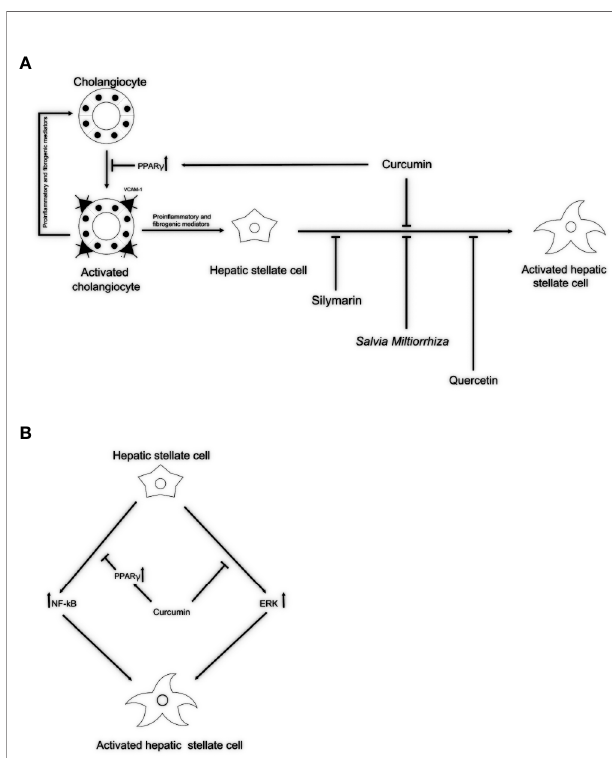
FIGURE 1 | Potential anti- fi brotic properties of natural remedies in cholangiopathies. (A) By activation of PPAR g , curcumin might block reactive cholangiocytes and their in fl ammatory activation through the reduction of VCAM-1 expression, resulting in decreased attraction of immune cells. Silymarin, Salvia miltiorrhiza, and quercetin might exert its anti fi brotic properties acting directly on HSCs activation. (B) In addition, acting as PPAR g activator and by inhibiting the ERK signaling curcumin might block HSCs activation. This dual role of curcumin could explain the anti fi brotic properties exerted in experimental models and clinical trials. PPAR g , peroxisome proliferator-activated receptor gamma; VCAM-1, vascular cell adhesion molecule 1; ERK, extracellular signal – regulated kinases; HSCs, hepatic stellate